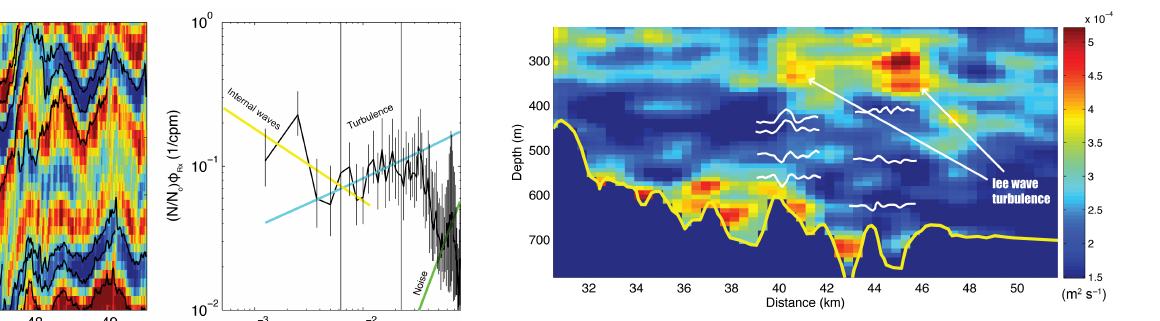
Figure 10. Final map of turbulent diffusivity across line Limon1 at resolution 400m by 10m. White tracks of seismic reflections along the large amplitude lee waves are shown for reference. We observe elevated turbulence near the rough bathymetry and above the lee waves at 40 and 45km. Levels of turbulent diffusivity are signifi- cantly higher above the lee waves structures and ∼ 50 times higher than the abyssal open